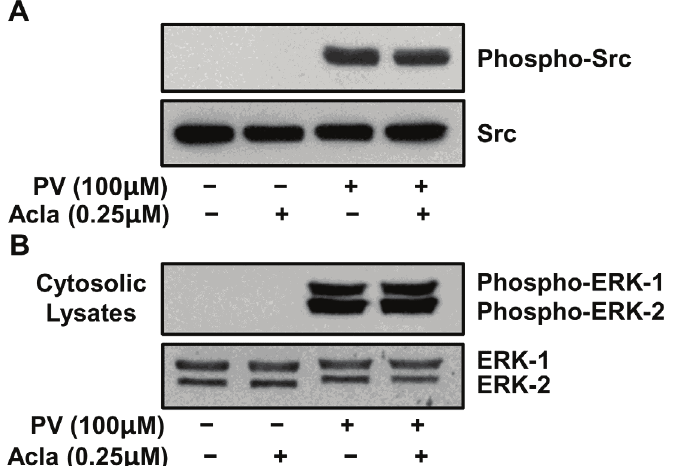
Figure 3. Proteasome inhibition does not impact PV-mediated activation of Src or MEK kinases. ILU-18 cells were treated with PV (100 (cid:4)M) for 20 min, with or without prior treatment with Aclacinomycin (0.25 (cid:4)M) for 2 h. At the end of incubation, cells were washed and cytosolic lysates prepared. As controls, cell lysates were made from ILU-18 cells left untreated or treated with 0.25 (cid:4)M Aclacinomycin alone for 140 min. Lysates, equalized for 30 (cid:4)g protein, were resolved using SDS-PAGE, followed by Western blotting using antibodies to phospho-Src (Tyr-416) and Src ( A ); or antibodies to phospho-p44/p42 ERK1/2 (Thr-202/Tyr-204) and ERK1/2 ( B